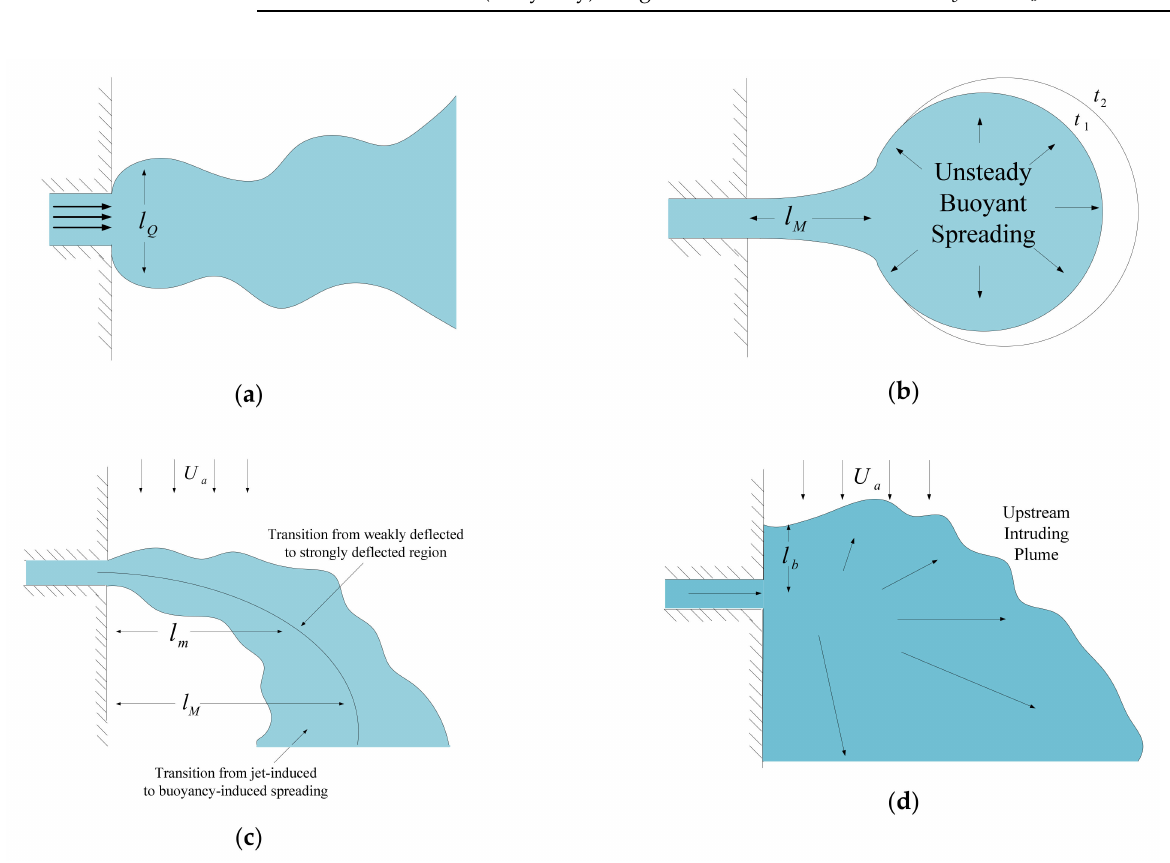
Figure 2. Representation of introduced length scales in stagnant ( a , b ), and cross-flow ( c , d ) ambient water